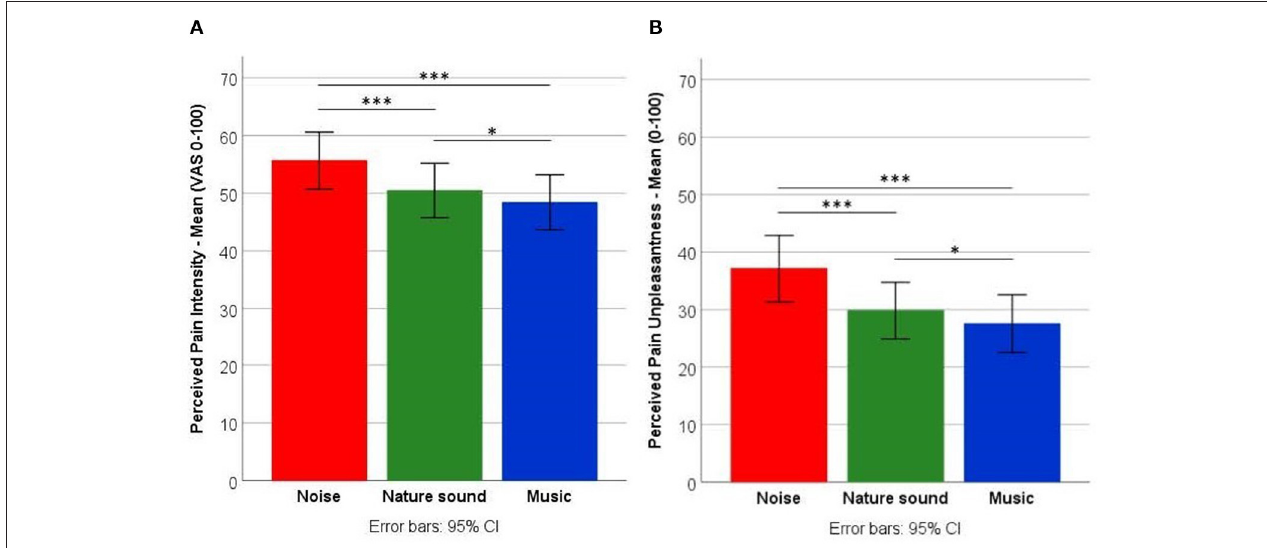
FIGURE 2 | Pain levels. Comparisons of noise, nature sound, and music on (A) pain intensity and (B) pain unpleasantness (regardless of pharmacological manipulations). * p < 0.05; *** p < 0.001.